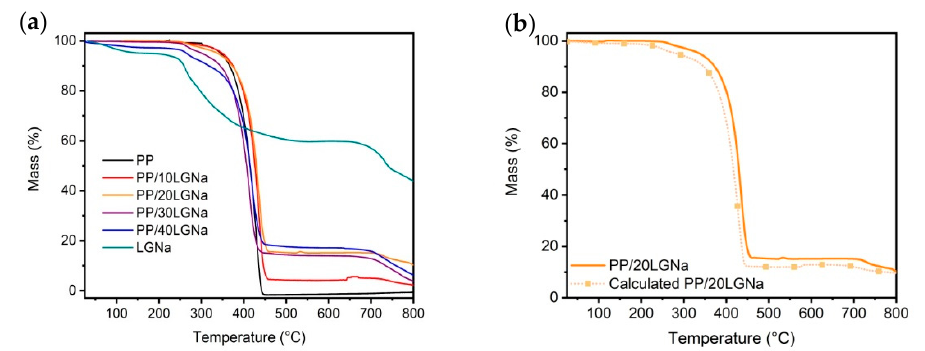
Figure 3. Thermogravimetric curves of PP, LGNa, and its blends ( a ) and comparison of the expected and experimental thermogravimetric curves of the PP/LGNa blend with 20 wt% of LGNa ( b ).